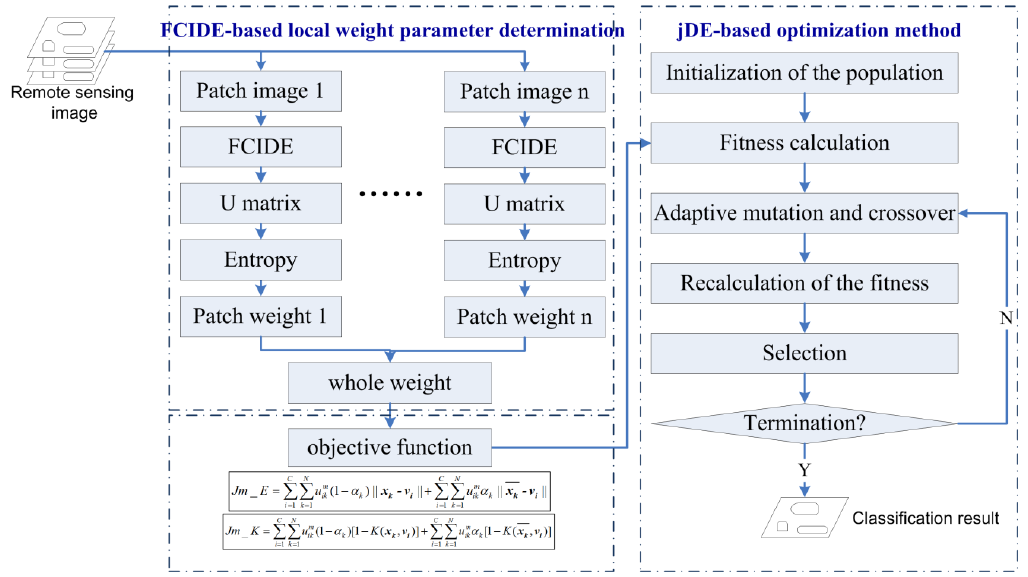
Figure 4. Flowchart of the proposed method L-SSC.